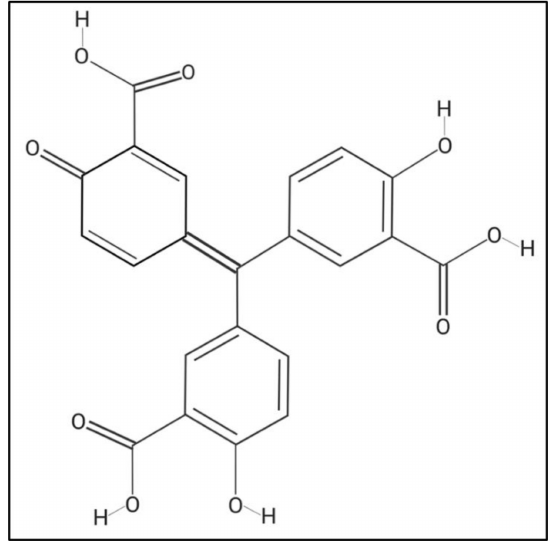
Figure 1. Chemical structure of aurintricarboxylic Acid (ATA). Molecular weight = 422.3 g / mol. Compound ID in PubChem